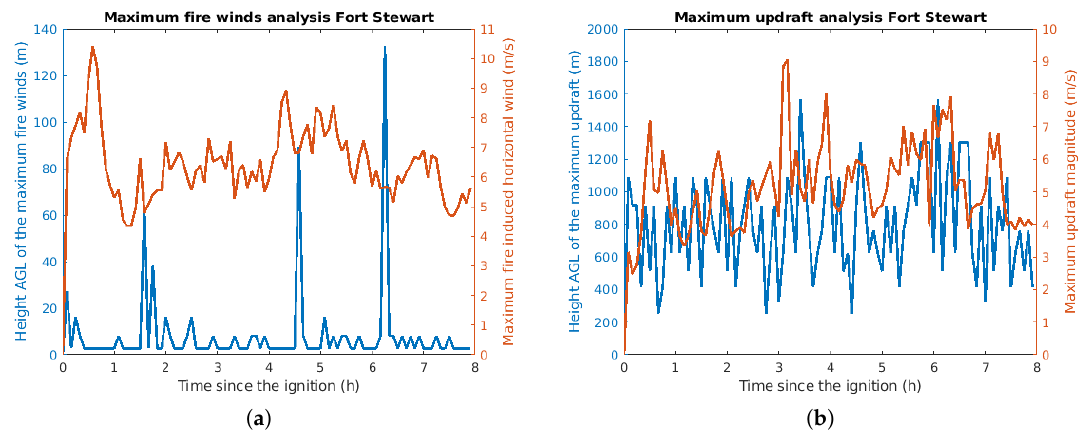
Figure 12. Analysis of the fire-induced wind and updraft for the Fort Stewart simulation executed for 04/22/2014. ( a ) Time series of the fire-induced maximum horizontal wind speed; ( b ) Same for the